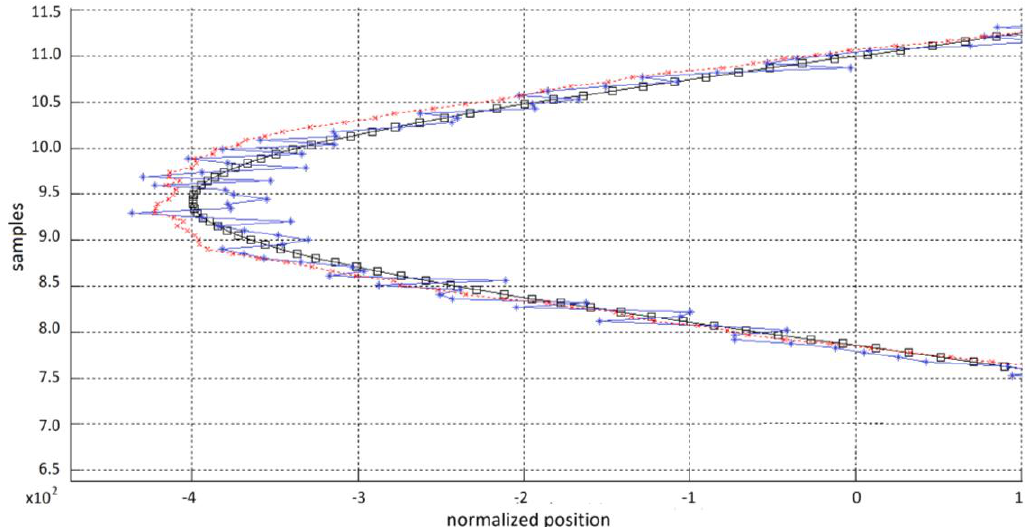
Figure 12. Kalman filtering as state estimator in mouse control and jitter removal; target movement (black line), observed movement (blue line), and filtered movement (red